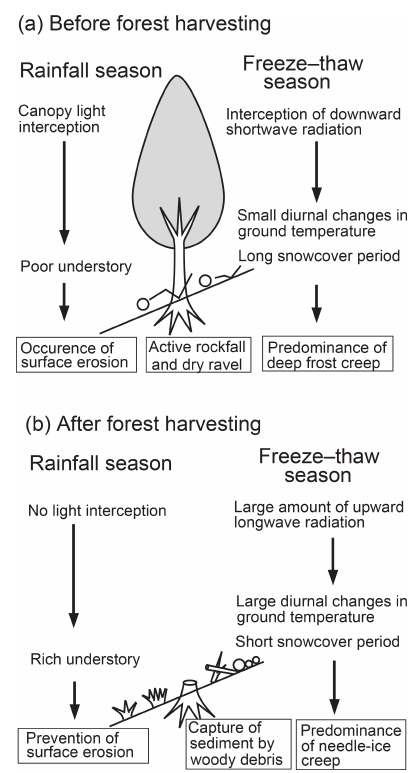
Figure 15. Difference in the hydrogeomorphic processes before and after forest harvesting on steep slopes in humid periglacial